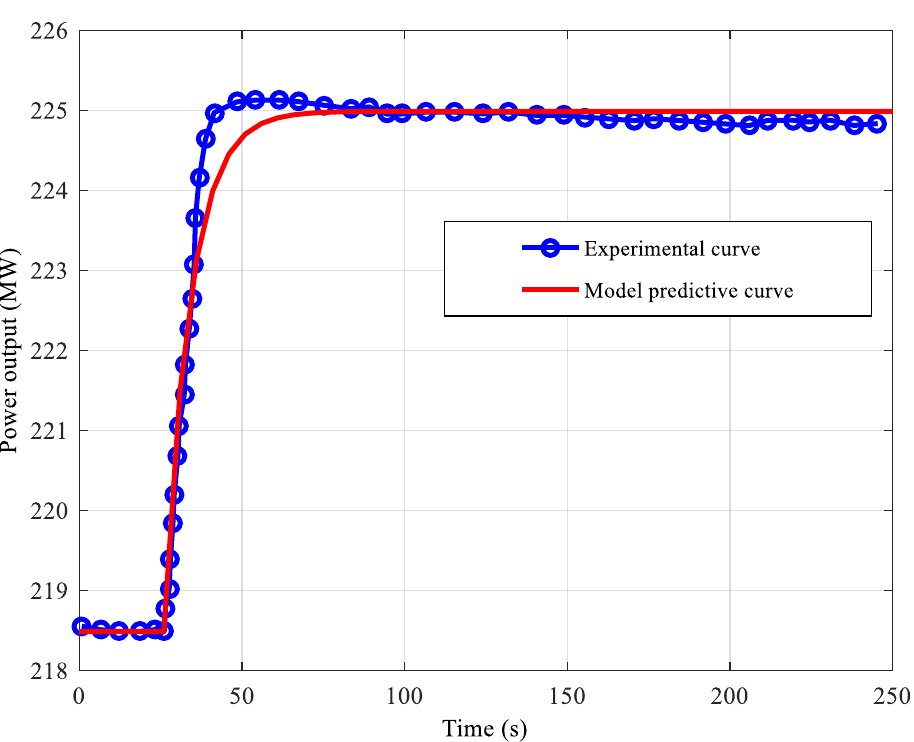
Figure 4. Experimental and model predicted curves of heat source extraction flow and power output.